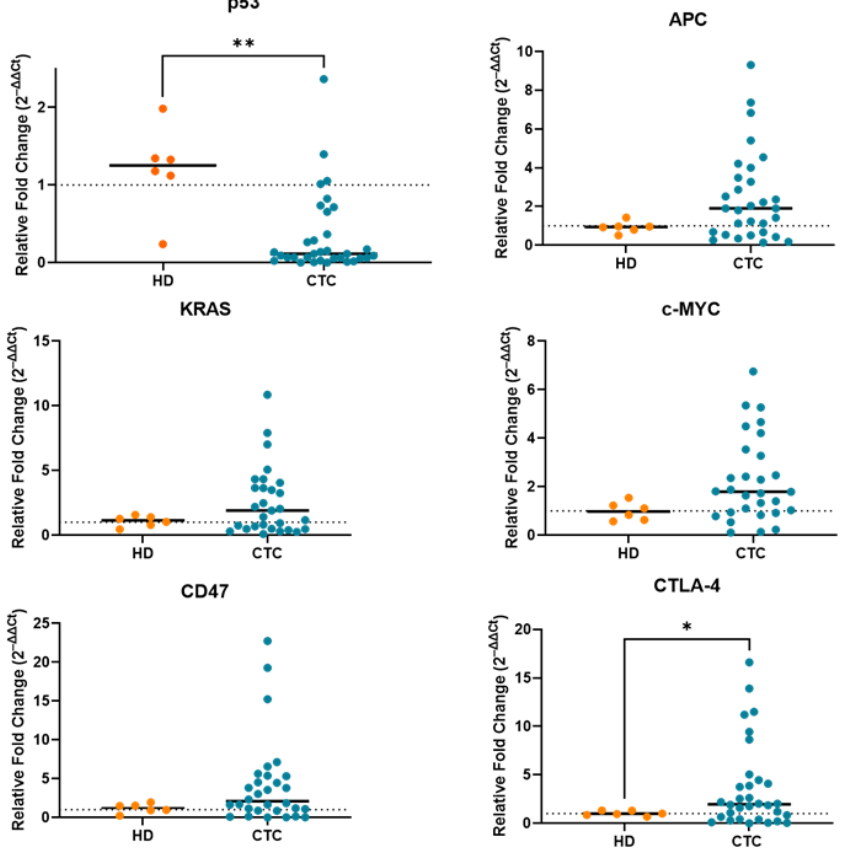
Figure 2. Relative fold change values (2 – ∆∆ Ct ) of p53 , APC , KRAS , c-Myc and CD47, CTLA-4 in CTC-enriched fraction from patients with CRC and from healthy donors (HDs) ( n = 6). All the values are plotted as a scatter plot with the median. Line indicates the normal fold change value. ** p < 0.005, * p < 0.05.